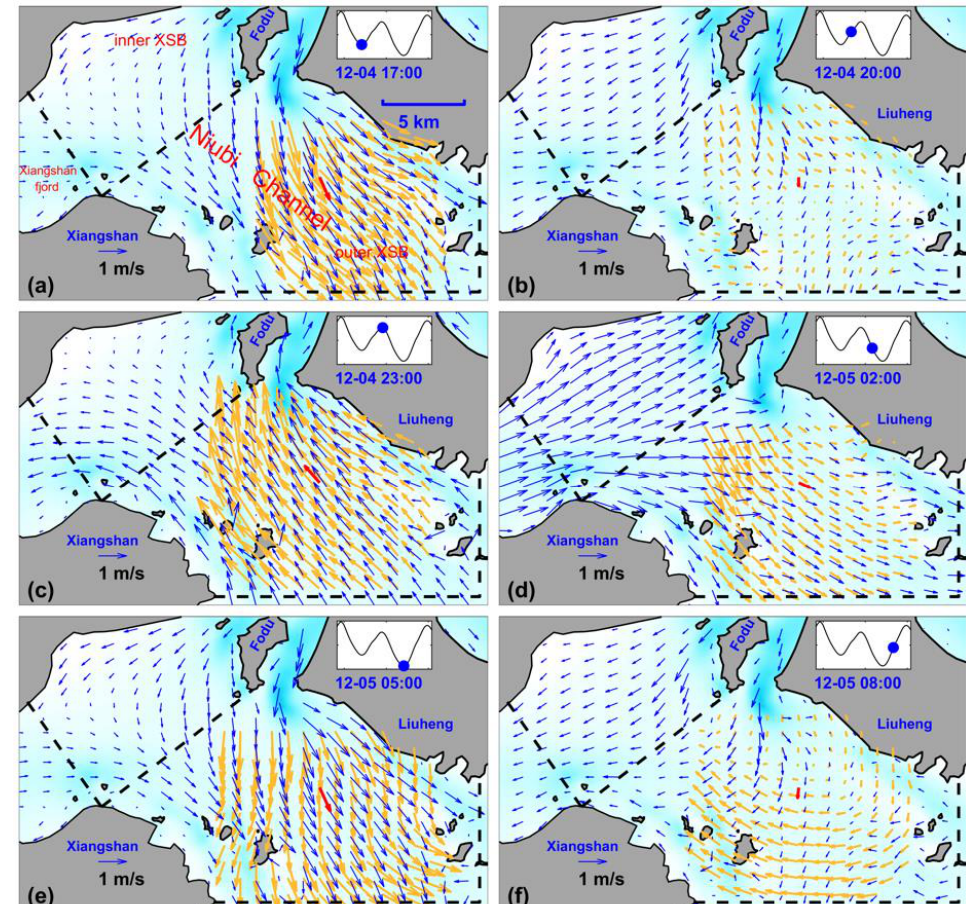
Figure 9. ( a – f ) Surface current distributions in the XSB with 3 h intervals. The blue, red, and yellow vectors indicate the currents that were modeled with Case3, ADCP, and vector synthesis by HFR observation, respectively. The blue shading below the arrows represents the depth (see the legend in Figure 1). The corresponding tidal level of C1 and time are shown in the upper right corner of each panel.